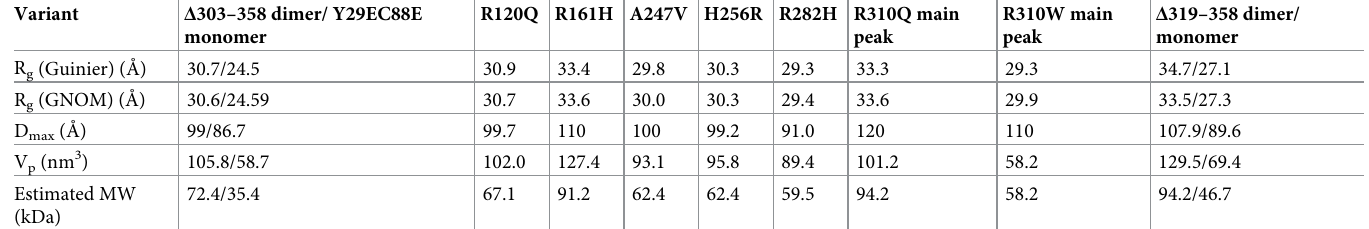
Table 2. SAXS parameters. Data for wild-type GDAP1 as well as the monomeric mutation Y29EC88E are taken from [11]. The MW estimate corresponds to the Bayesian estimate from PRIMUS.